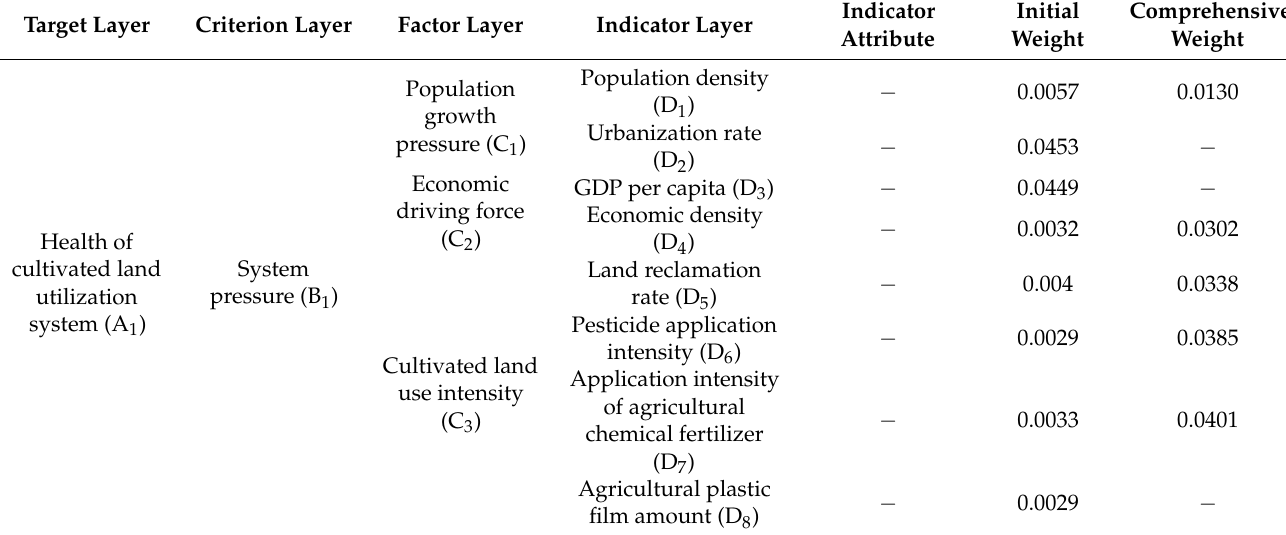
Table 2. Health evaluation index system in the two lake